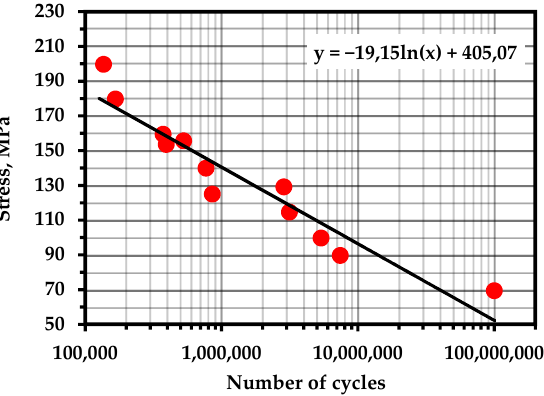
Figure A3. S–N Curve—Ti–6Al–4V (Temperature—298 К ; frequency—110 Hz). Source—Base Total Material.